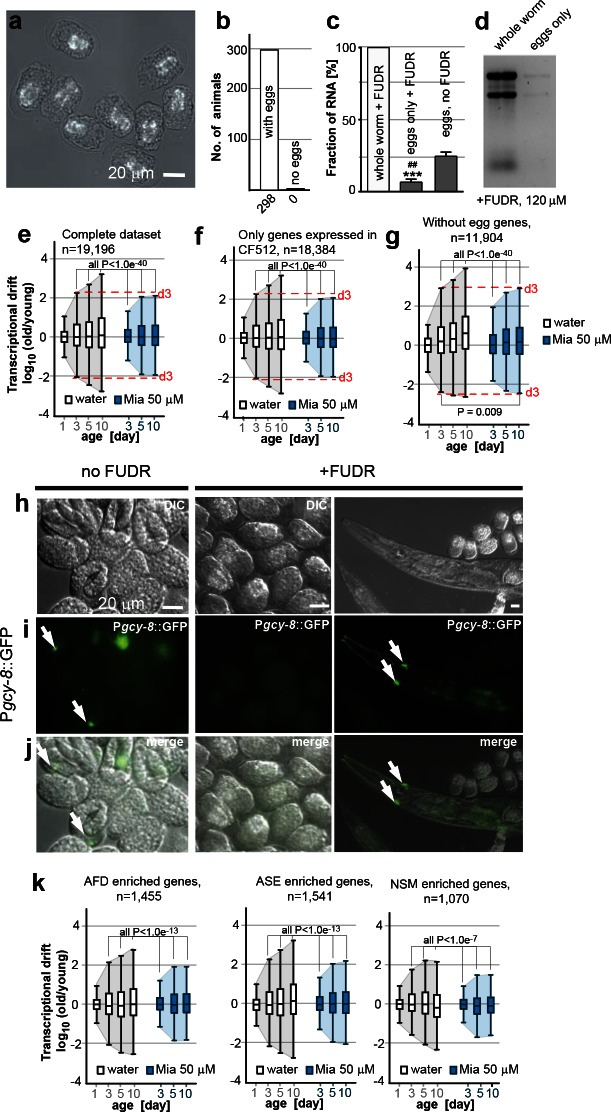
Egg RNA does not affect drift-variance.(a) DIC photomicrograph of eggs obtained from FUDR (120 µM final) treated animals. Eggs are terminally arrested around the ventral closure (“bean stage”, 400–500 nuclei) and show a shrunken cell mass. Birefringent gut granules are observed in the middle of the eggs. Images were taken ~48 hr after FUDR treatment. (Scale bar = 20 µm). (b) Number of adult worms that produce eggs 24 hr after FUDR treatment. Of the 298 worms evaluated, all of the animals developed germline with eggs inside. (c) Treatment with FUDR dramatically reduces the RNA content in eggs. Total RNA was extracted from FUDR-treated whole wt (N2) worms, from eggs isolated from FUDR-treated N2 worms after ~28 hr of FUDR treatment and from eggs from non-FUDR-treated N2 worms (the same time point as the RNA-seq young reference),. ***P<0.001, comparison between whole worms and eggs treated with FUDR, unpaired t-test, n=3, Error bars S.E.M; ##P<0.01, comparison between eggs treated with FUDR and no FUDR, unpaired t-test, n=3, Error bars S.E.M. (d) Electrophoresis of RNA extracted from whole worms or eggs isolated from FUDR treated animals. Same number of animals used for each sample. Comparison of equal volumes (10 µl) of total RNA loaded from FUDR-treated whole worms and eggs isolated from FUDR-treated animals, resolved in an agarose gel. (e) Original drift plot from Figure 2a is shown again for comparison. Note that box in the middle of the drift plot, which is a Tukey-pl﻿ot, represents the interquartile mean, or 50% of the transcriptome that changes less with age. As drift is also observed in the interquartile mean, drift is not driven by extreme outliers, but by the majority of the genes across the entire transcriptome. (f) Drift plot generated from our data-set only including genes that were also detected in the CF512 sterile strain data-set from (Murphy et al., 2003). (g) Drift plot generated after removing 7,292 genes involved in egg-related functions detected from an eggs-only RNA-seq data-set (Osborne Nishimura et al., 2015). (h) DIC photomicrograph of eggs obtained from untreated and FUDR-treated animals carrying the Pgcy-8::GFP reporter for AFD neurons. (i) Fluorescence microscopy images show AFD neurons in eggs derived from untreated adults (left panel, white arrows) but not in eggs obtained from FUDR-treated adults (middle panel), confirming that FUDR treated eggs do not progress past the “bean stage”. FUDR does not inhibit Pgcy-8::GFP expression in adults (right panel). (j) Overlay of h and i. (k) Drift plots using our data-set including only the genes that are highly enriched in AFD, ASE or NSM neurons (Etchberger et al., 2007; Spencer et al., 2014). As FUDR arrests embryonic development before the birth of these neurons, the drift-plots cannot be influenced by RNA derived from eggs. Explanations for Figure 2—figure supplement 2 In the experiments presented in the main manuscript, we used FUDR to sterilize the animals from which we subsequently extracted RNA for RNA-seq. Thus, our samples contained fractions of egg RNA. The following control experiments and analysis show that the fraction of RNA in our samples coming from eggs is small and does not influence the phenomenon of transcriptional drift and its attenuation by mianserin. We first isolated eggs from FUDR-treated and untreated animals. FUDR treatment causes the cell mass inside the eggs to shrink and to terminally arrest at around bean stage (400–500 nuclei) (Figure 2—figure supplement 2a). FUDR-treated animals all contained similar numbers of eggs 24 hr after FUDR treatement (n=298) (Figure 2—figure supplement 2b) Note that many of the reported FUDR side-effects such as a lack of germline are not observed in 96-well liquid culture (Gomez-Amaro et al., 2015). Extracting RNA from whole worms or eggs isolated from whole worms showed that FUDR-treated eggs contained 5 times less RNA compared to untreated eggs. The fraction of RNA originating from the eggs in FUDR-treated worms was roughly ~5% (Figure 2—figure supplement 2c,d). We next asked whether this fraction could in anyway influence the phenomenon of transcriptional drift. The original plots (Figure 2a, or Figure 2—figure supplement 2e) of the entire transcriptome show that drift-variance increases in the interquartile mean (boxes) showing that it is not driven by a set of outlier genes, making it unlikely that the 5% fraction would influence drift-variance (Krzywinski and Altman, 2014). Nevertheless, to test possible interference, we calculated drift plots for various subsets of our data excluding transcrips expressed in eggs. The Murphy data were derived from CF512 (sterile) animals and thus any genes detected do not originate from eggs. We therefore excluded all genes not detected by Murphy et al from our data-set and recalculated drift. The resulting drift plot still shows a dramatic increase in drift-variance and attenuation by mianserin (Figure 2—figure supplement 2f). A potential problem with the approach used in Figure 2—figure supplement 2f is that it only removed eggs/germline genes that are specific for eggs but that it did not remove genes that are present in both eggs and soma. We therefore removed all genes that were identified in C. elegans eggs by RNA-seq from our data-set to plot Figure 2—figure supplement 2g (Osborne Nishimura et al., 2015). Of the 7,700 transcripts identified in eggs, 7,200 were present in our data-set. Note that this approach removes all ubiquitously expressed genes like ribosomal, mitochondrial and similar housekeeping genes that are present in both embryos and soma. Even though this operation removes only 7,200 out of 19,196 individual genes present in the data-set, these 7,200 genes account for 73% of total mRNA counts. Despite this dramatic reduction in overall mRNA transcripts, the drift plot combining the remaining 11, 904 genes (mostly low expressing genes) confirms an increase in drift-variance with age that is suppressed by mianserin (Figure 2—figure supplement 2g). To identify gene-sets that cannot possibly originate from the FUDR-treated eggs we exploited the specific arrest in embryonic development caused by FUDR. The DIC images suggested that FUDR arrests embryonic development before the birth of AFD, ASE and NSM neurons. If so, genes in our data-set that are specifically expressed in these neurons have to originate from the adult somatic tissue. To test that FUDR treatment prevents the birth of these neurons, we imaged eggs of C. elegans carrying a Pgcy-8::GFP transgene (AFD marker) (Figure 2—figure supplement 2h, i, j). Eggs from untreated animals showed a clear expression of the marker while FUDR-treated eggs did not (Figure 2—figure supplement 2i, j (n>100)). FUDR did not repress the expression of the Pgcy-8::GFP transgene in adults, showing that the lack of a Pgcy-8::GFP signal in FUDR-treated eggs is due to an arrest before the neurons are born and not due to inhibition of the reporter expression by FUDR. As AFD neurons are born before ASE and NSM neurons, these results suggested that none of these three neurons are present in FUDR-treated eggs (Sulston et al., 1983). After having established the absence of AFD, ASE and NSM neurons in eggs derived from FUDR treated animals, we then used the published gene-sets that are highly enriched in these three neuron types (AFD, ASE, NSM) to construct drift-plots (Etchberger et al., 2007; Spencer et al., 2014). Even for these highly restricted sets of genes, drift-variance dramatically increased with age and was repressed by mianserin. Taken together, these results show that the RNA contamination from FUDR-treated eggs is minimal and that this residual amount does not influence our results.